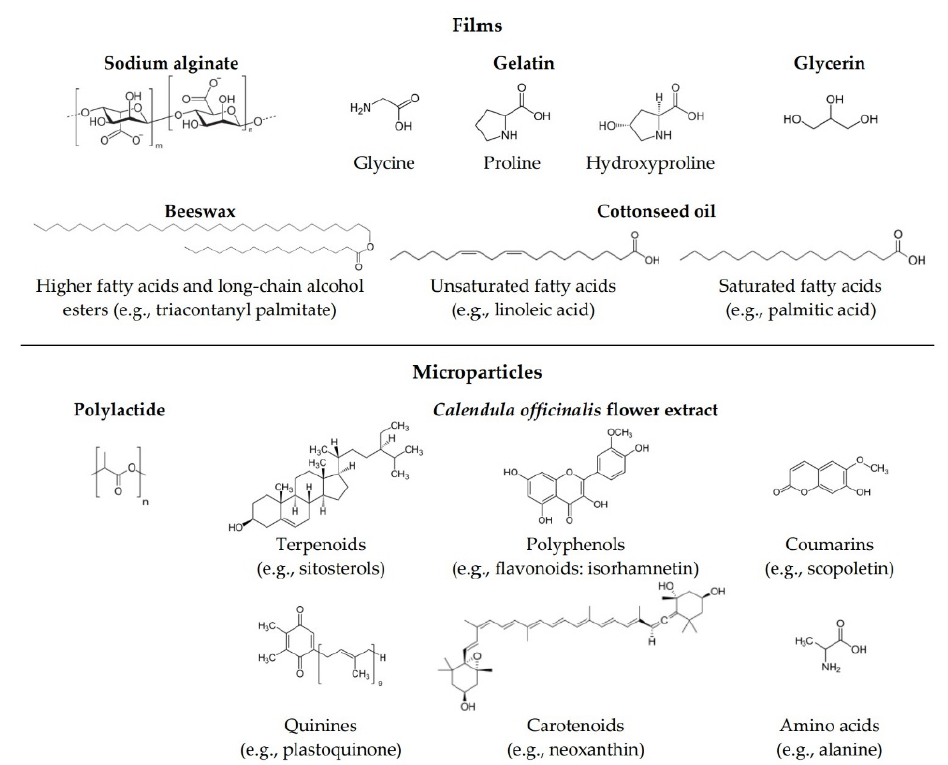
Figure 1. The structure of sodium alginate, glycerin and main constituents of gelatin, beeswax and cottonseed oil used for preparation of films; polylactide for encapsulation; main constituents of Calendula officinalis flower extract enclosed in microparticles.